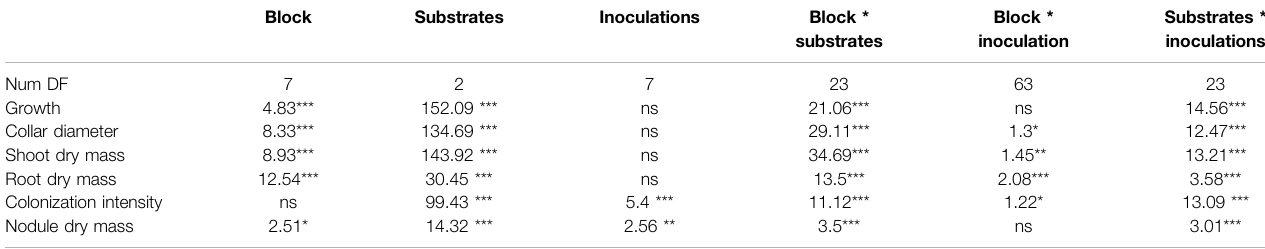
TABLE 3 | Signi fi cance level obtained from two-way ANOVA testing the effects ofinoculation and substrates on different parameters measured in the nursery and mine fi eld conditions. Block